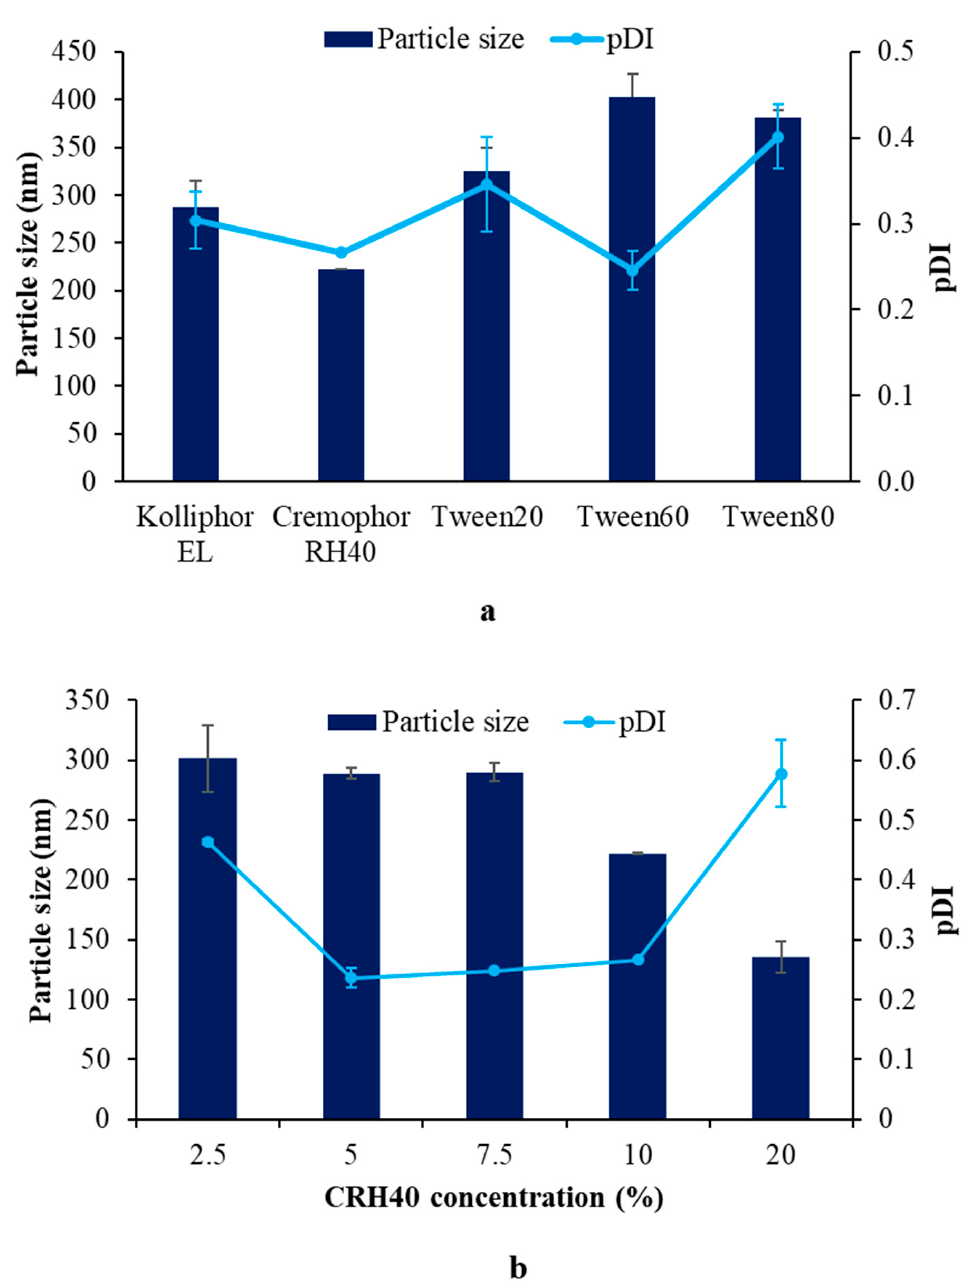
Figure 3. Effects of surfactant type ( a ) and concentration ( b ) on particle size and size distribution